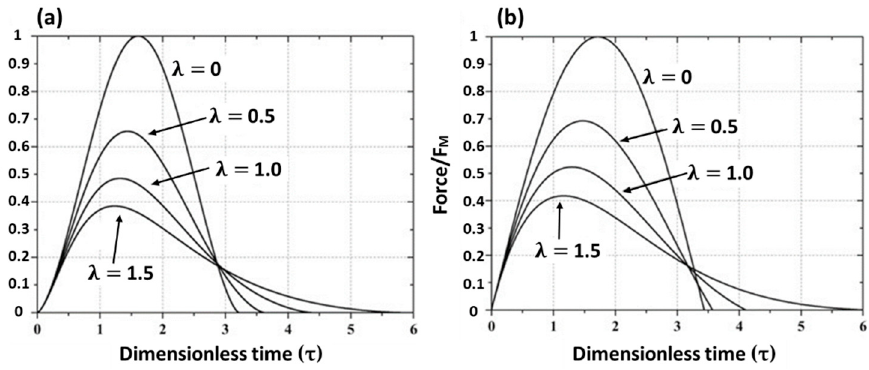
Figure 4. ( a ) Zener standard force–time collision curve [2,12]. ( b ) Boettcher et al. simplified the normalized force–time collision curve graph obtained from the analysis of the Zener equation [12].